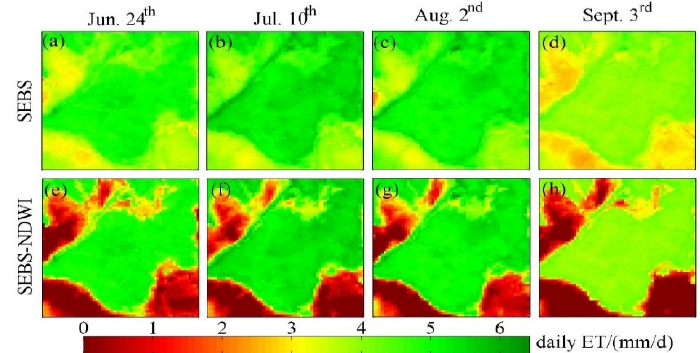
Figure 8. Daily evapotranspiration maps of the study area in 2012. Figure 8 show the daily evapotranspiration maps obtained with the original SEBS for 24 June ( a ), 10 July ( b ), 2 August( c ), and 3 September ( d ), respectively; and the daily evapotranspiration maps obtained with the NDWI-integrated SEBS for 24 June ( e ), 10 July ( f ), 2 August ( g ), and 3 September ( h ), respectively.